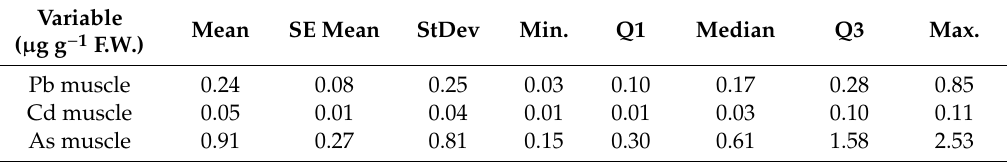
Table A7. Descriptive statistics of fifth group